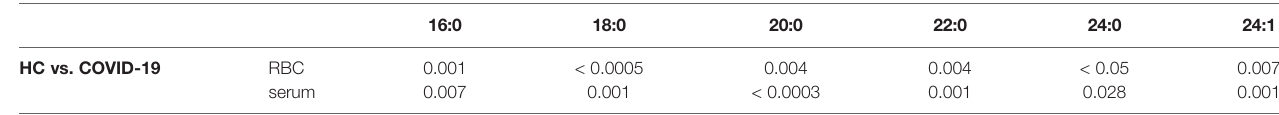
TABLE 2 | Overview on p-values on day of admission (day 1) to intensive care in samples obtained from COVID-19 patients either from serum or RBC with respect to ceramide concentration differing in chain length of acylated fatty acid 16:0 to 24:1.